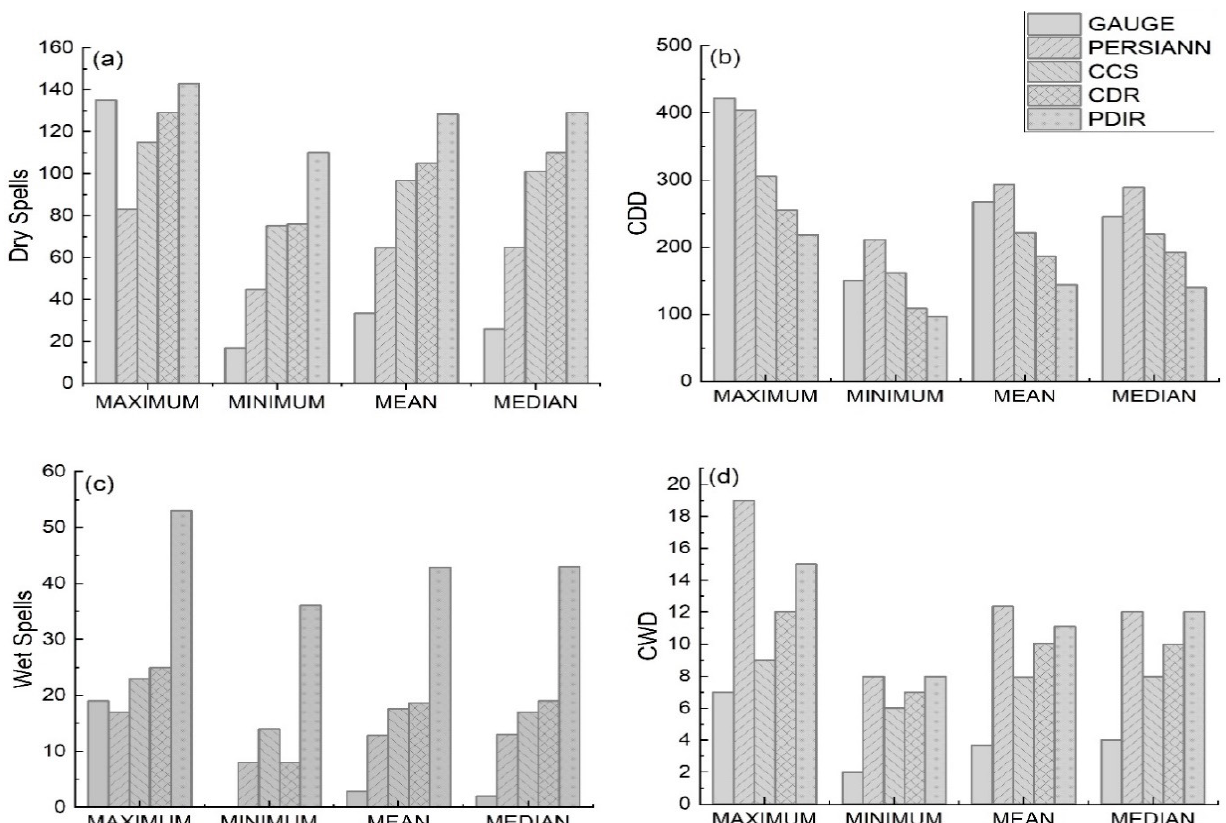
Figure 9. Representation of maximum, minimum, mean and median values of dry spells ( a ), wet spells ( c ), consecutive dry days (CDD) ( b ) and consecutive wet days (CWD) ( d ). CDD and CWD were calculated based on the threshold of 1 mm rainfall, while dry and wet spells were calculated by selecting 3 days of rainfall.